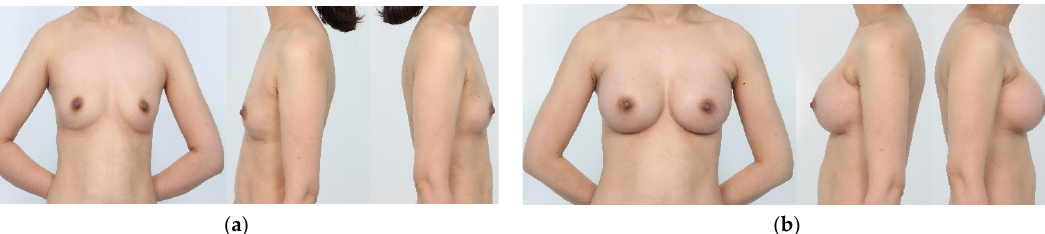
Figure 4. Illustrative case. A 38-year-old woman received the Motiva Ergonomix TM Round SilkSur- face (ERSF, 335 cc) for both sides of the breast. The patient was satisfied with the aesthetic outcomes